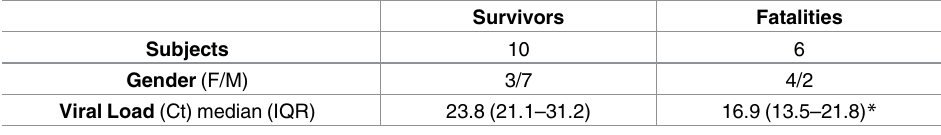
Table 1. Clinical features of enrolled Ebola-infected